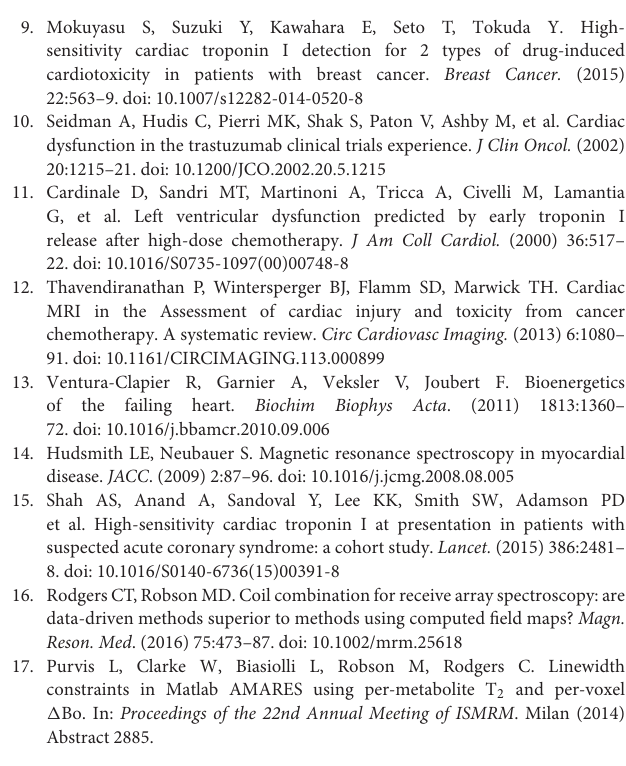
Supplementary Figure | Associations between the change in PCr/ATP ratio and change in LVEF during